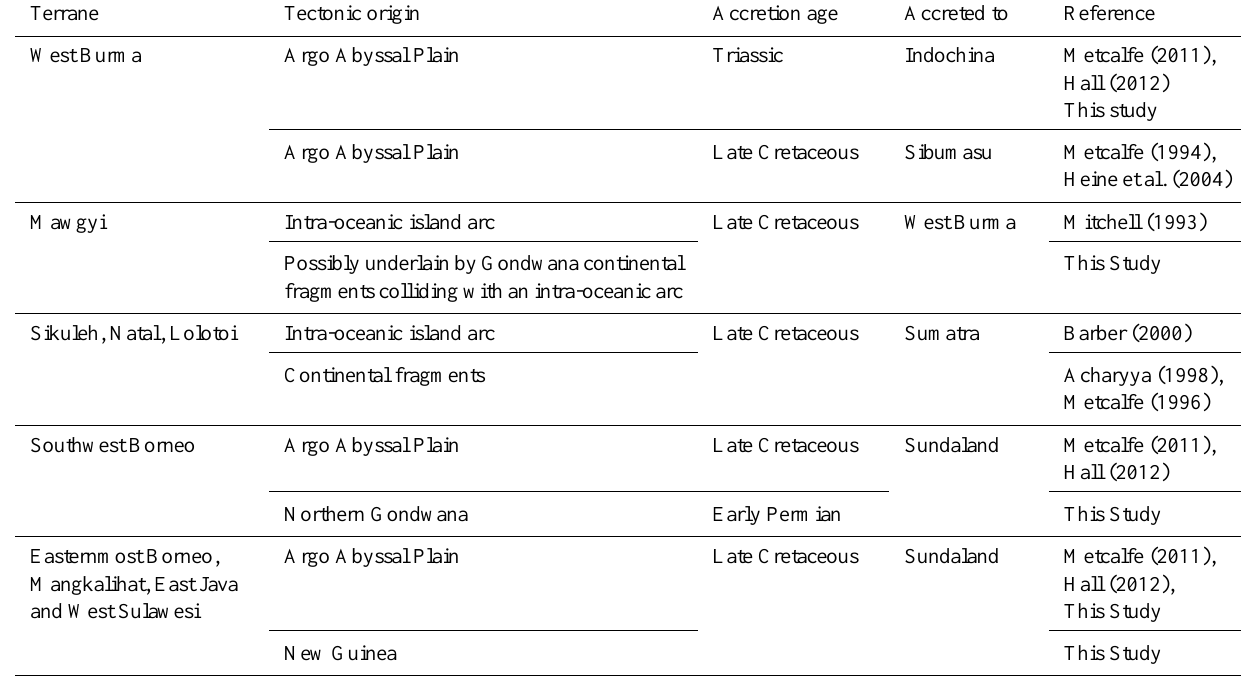
Table 3. The origin and present-day candidates for microcontinents that collided with the Neo-Tethyan intra-oceanic arc are controversial and vary substantially across published models. We acknowledge that the easternmost Borneo, Mangkalihat, East Java and West Sulawesi may have originated from either the Argo Abyssal Plain or the New Guinea margin. However, we do not believe that the southwest Borneo core rifted from northern Gondwana in the latest Jurassic with these